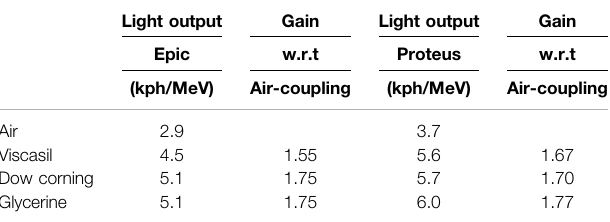
TABLE 2 | Light output measurements on 2 × 2 × 3mm 3 Ba F 2 crystals from Epic and Proteus, coupled to a Hamamatsu H6610 PMT with several optical coupling media and wrapped in several layers of Te fl on. The error in the measurements is about